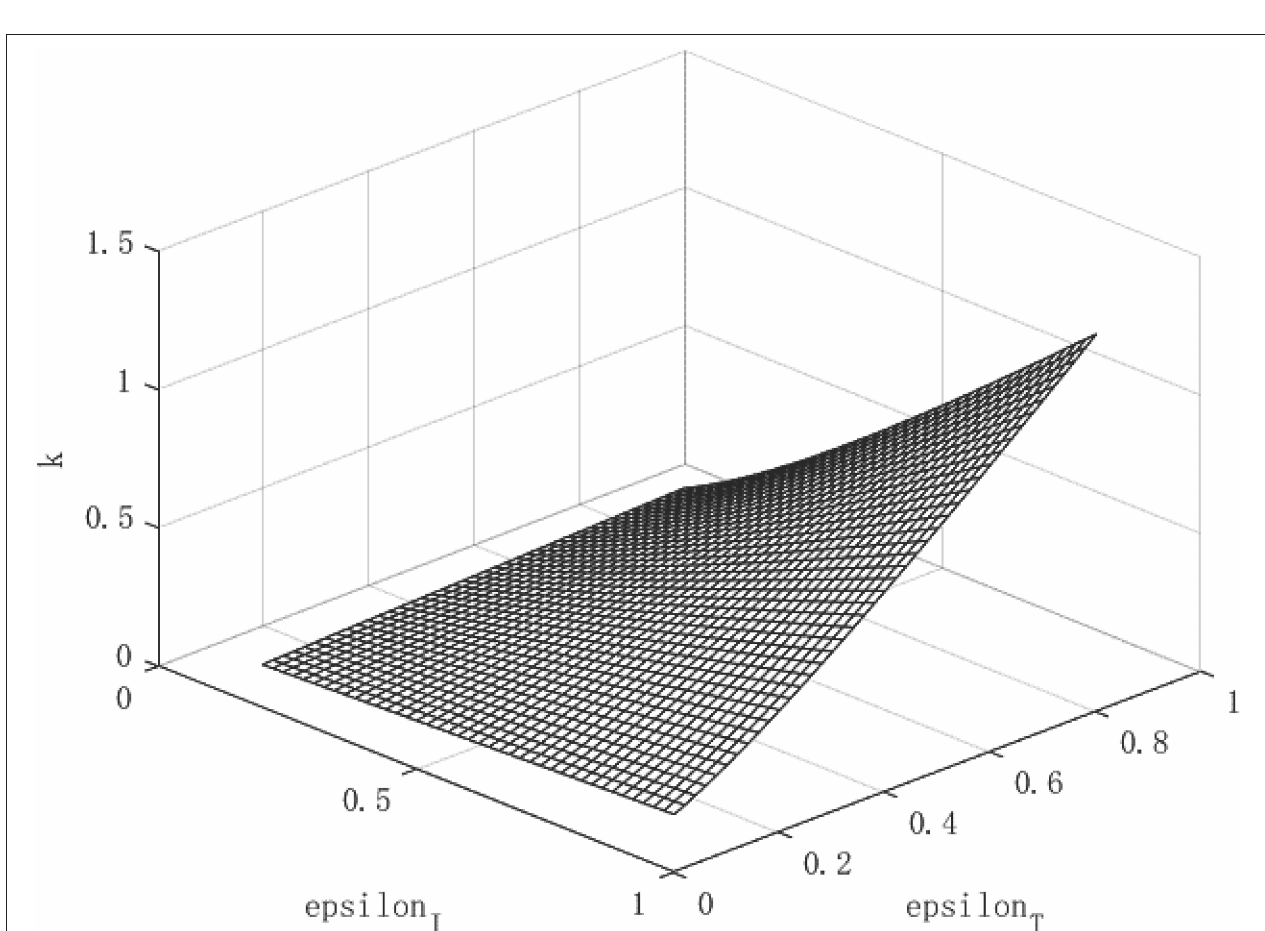
FIGURE 8 | Growth path of per capita capital under high contagious public health emergencies.